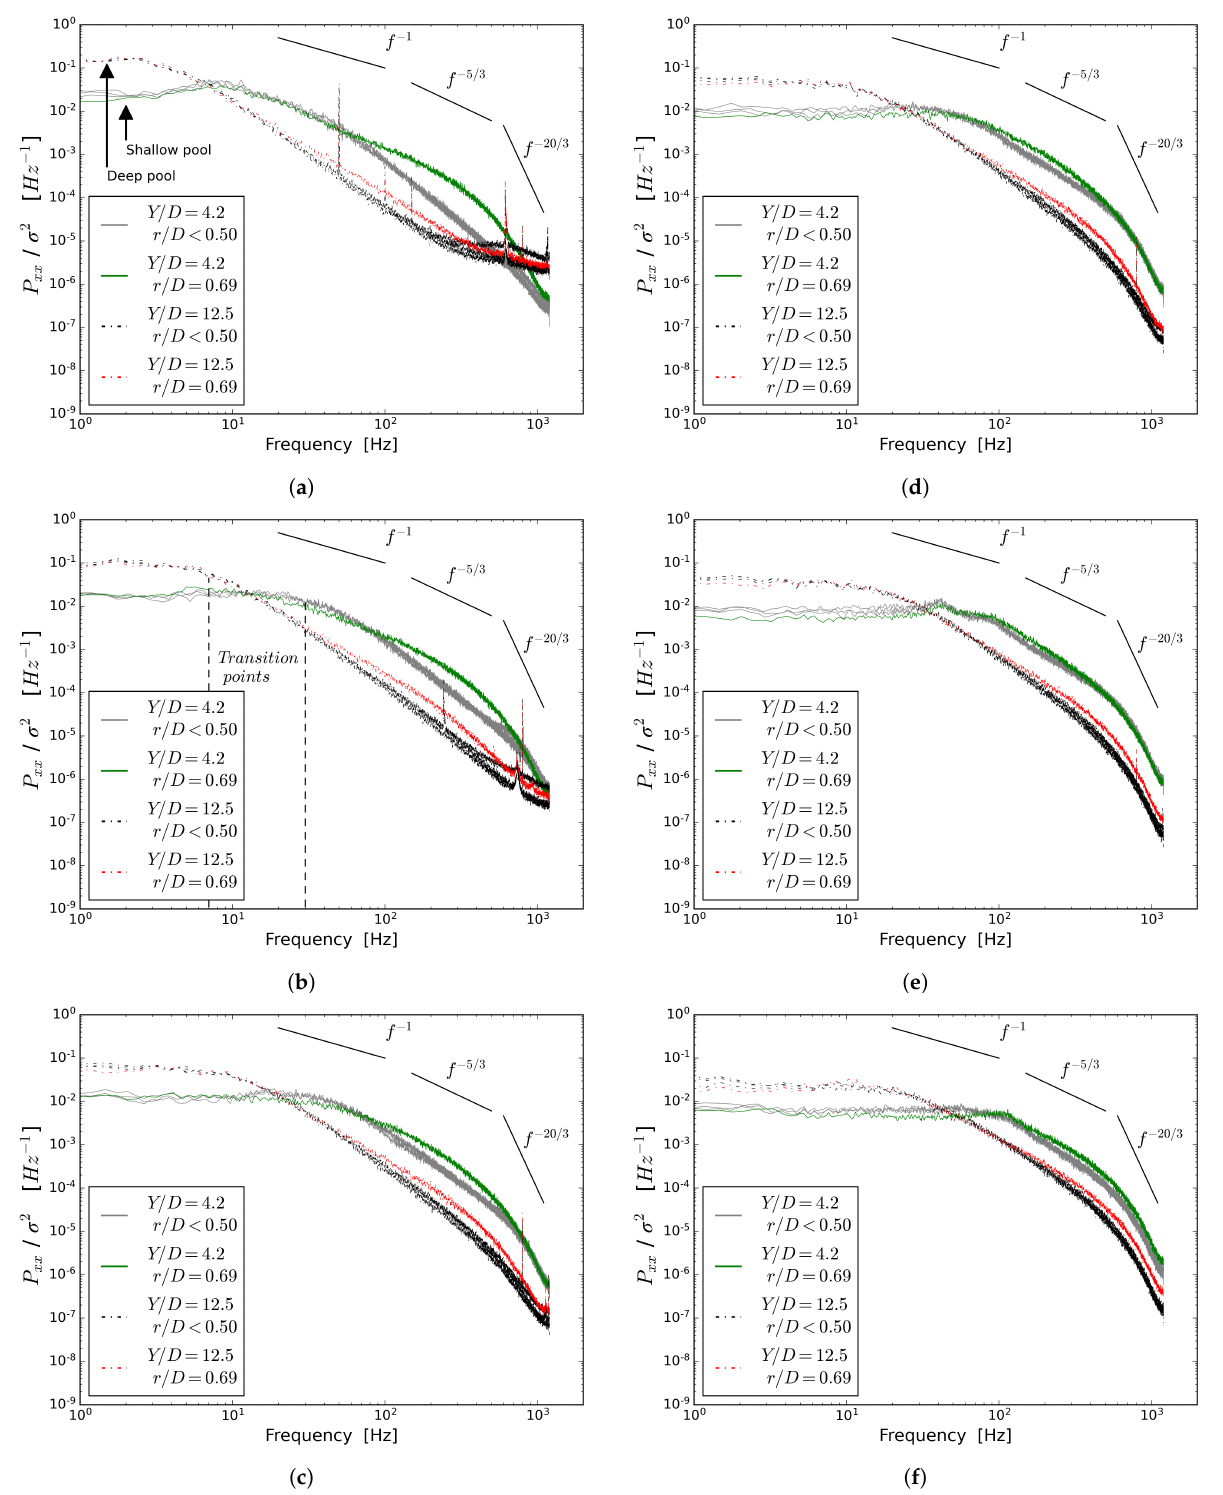
Figure 9. Evaluation of influence of Y / D (shallow/deep pool), radial distance r / D and velocity V on non-dimensional spectral content P xx / σ 2 [Hz − 1 ]. ( a ) V = 5.0 m/s; ( b ) V = 7.4 m/s; ( c ) V = 9.8 m/s; ( d ) V = 12.0 m/s; ( e ) V = 14.7 m/s; ( f ) V = 18.0